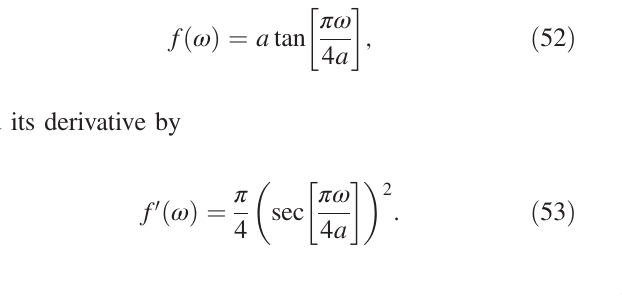
FIG. 2. Dependence of E on azimuthal angle ϕ − ϕ 0 normal- z ized by a factor of − 2 Q=a 2 for the case of an off axis displaced particle. Orange line: r ¼ r 0 ; Green line: r ¼ a= 10 ; Blue line: r ¼ a . Points are results for the direct simulation using the mode decomposition method [23,24] (1000 radial and 15 azimuthal modes were taken in to account) and the solid lines are calculated using the